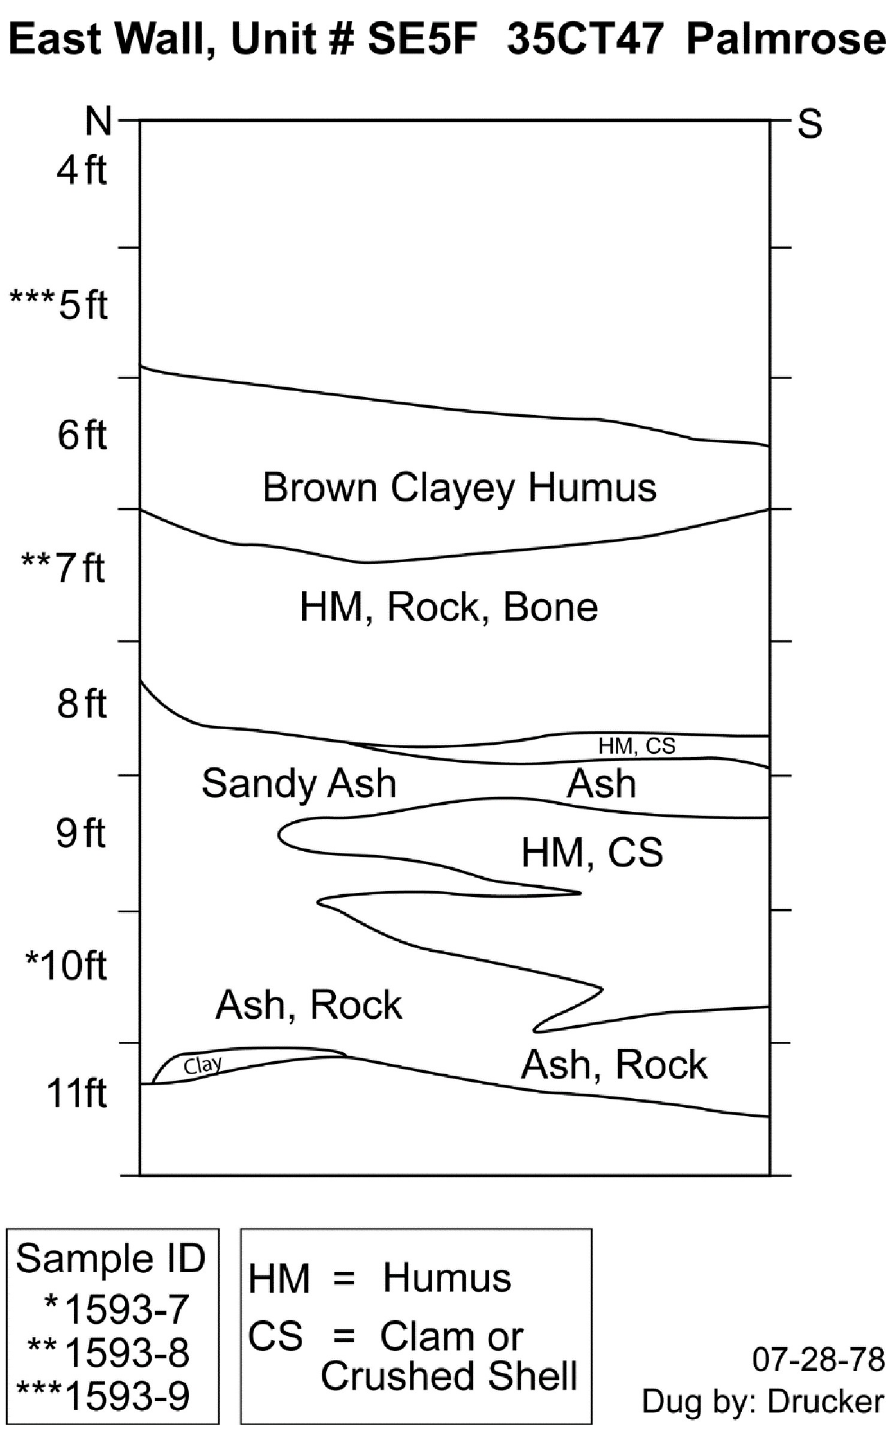
Fig 6. Palmrose unit SE5F east wall profile. Level provenience of radiocarbon samples